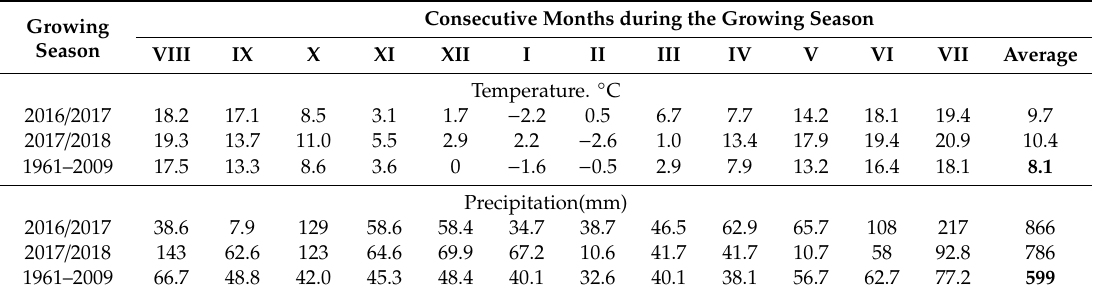
Table 2. Main characteristics of meteorological conditions during the study on the background of the long-term averages 1